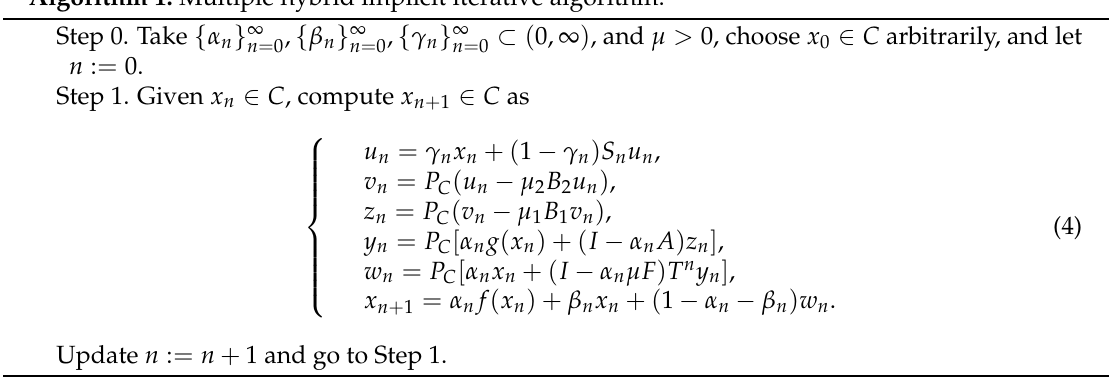
Algorithm 1: Multiple hybrid implicit iterative